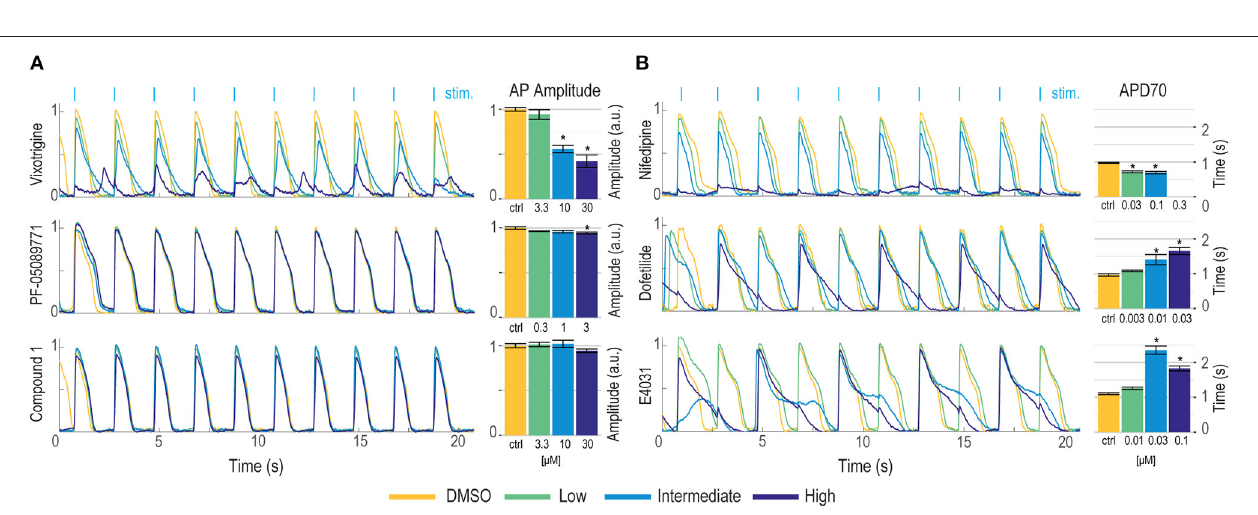
FIGURE 7 | Validation of hiPSC-derived cardiomyocyte counter-screening assay on Swarm instrument with pharmacological tool compounds and an identified screening hit. Representative BeRST1 voltage fluorescence traces are shown for 0.5Hz paced cardiomyocytes treated with increasing concentrations of compound (yellow to dark blue). Cardiomyocytes were treated with (A) sodium channel blockers (Vixotrigine, PF-05089771, QS Compound 1) and (B) calcium channel and hERG channel blockers (Nifedipine, Dofetilide, E4031). Quantification of (A) action potential (AP) peak amplitude for sodium channel blockers and (B) AP70 width for calcium channel and hERG channel blockers are shown as mean ± SEM from triplicate wells. * p < 0.05 compared to DMSO